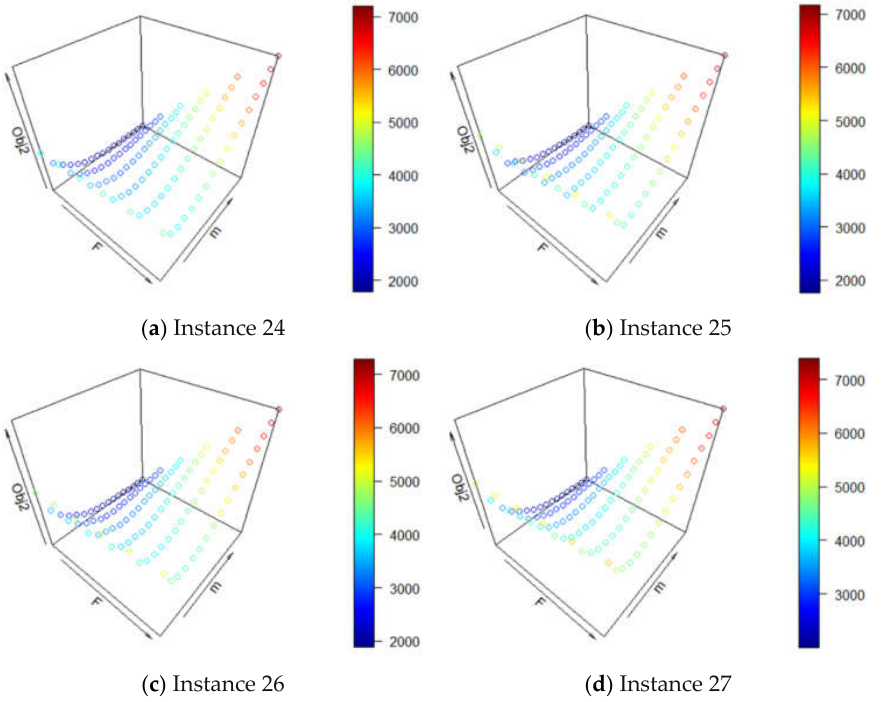
Figure 10. Cross-validation of m and F on the total cost while c = 0.15. ( a ) Instance 24; ( b ) Instance 25. ( c ) Instance 26; ( d ) Instance 27.